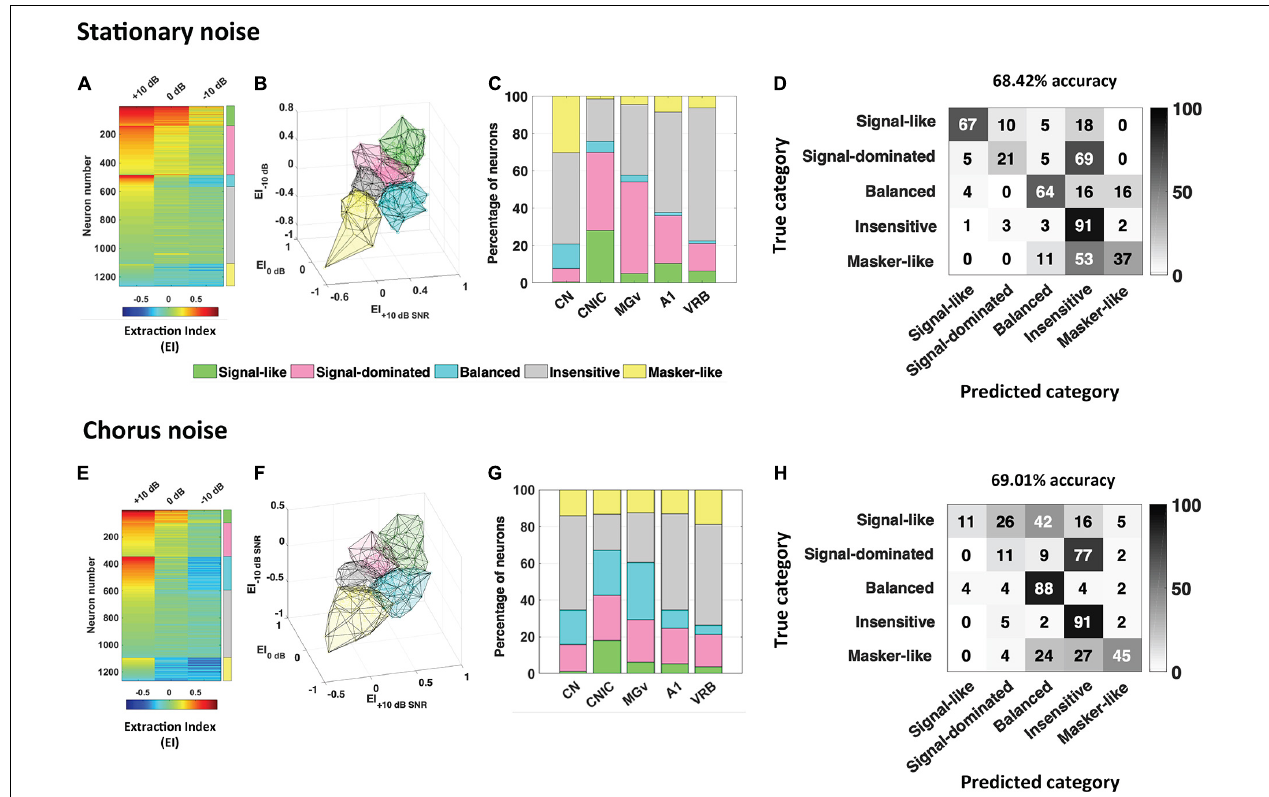
FIGURE 2 | Robustness to noise is a distributed and predictable property in the whole auditory system. The extraction index (EI) quantifies to what extent the evoked response at a given SNR is similar to the response to vocalizations in quiet or to noise alone. (A) Each row corresponds to the extraction Index (EI) profile of a given neuronal recording obtained in the five auditory structures (CN, CNIC, MGv, A1, and VRB) in stationary noise with a color code from blue to red when progressing from low to high EI values. The color coded column on the right, delineate the identity for the five categories of responses found, “signal-like” in green, “signal-dominated” in pink, “balanced” in turquoise, “insensitive” in gray, and “masker-like” in yellow. (B,C) 3D representation of the five categories in stationary noise (B) , and proportion of each category in the five auditory structures from CN to VRB (C) . (D) Confusion matrix obtained with descriptors extracted from pure tone responses, signal alone and stationary noise alone responses. Each row corresponds to a true category and each column corresponds to a predicted category. The numbers in the confusion matrix correspond to the percentage of recordings of a given true category which have been predicted to belong to a given predicted category. Around 70% of accuracy (68.42%) was reached with these descriptors. (E–H) Same representations as in (A–D) for the responses collected in the chorus noise. Modified from Souffi et al.